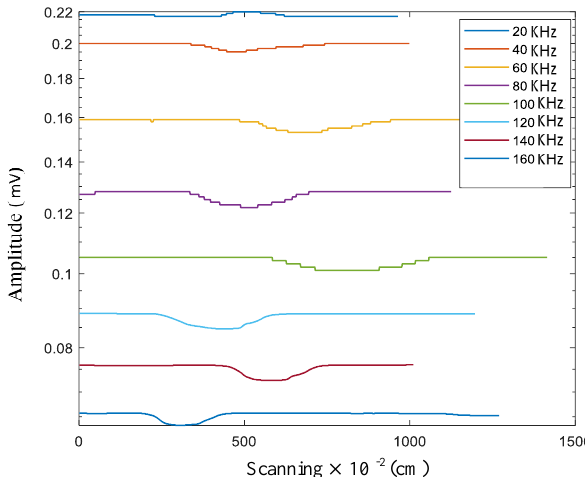
FIGURE 11. Results of the frequency scanning experiment for the eddy current testing system with inductive sensor. To determine the optimum excitation frequency of the eddy current testing system with the giant magnetoresistance sensor, we chose the same scanning excitation frequency range. The results show in